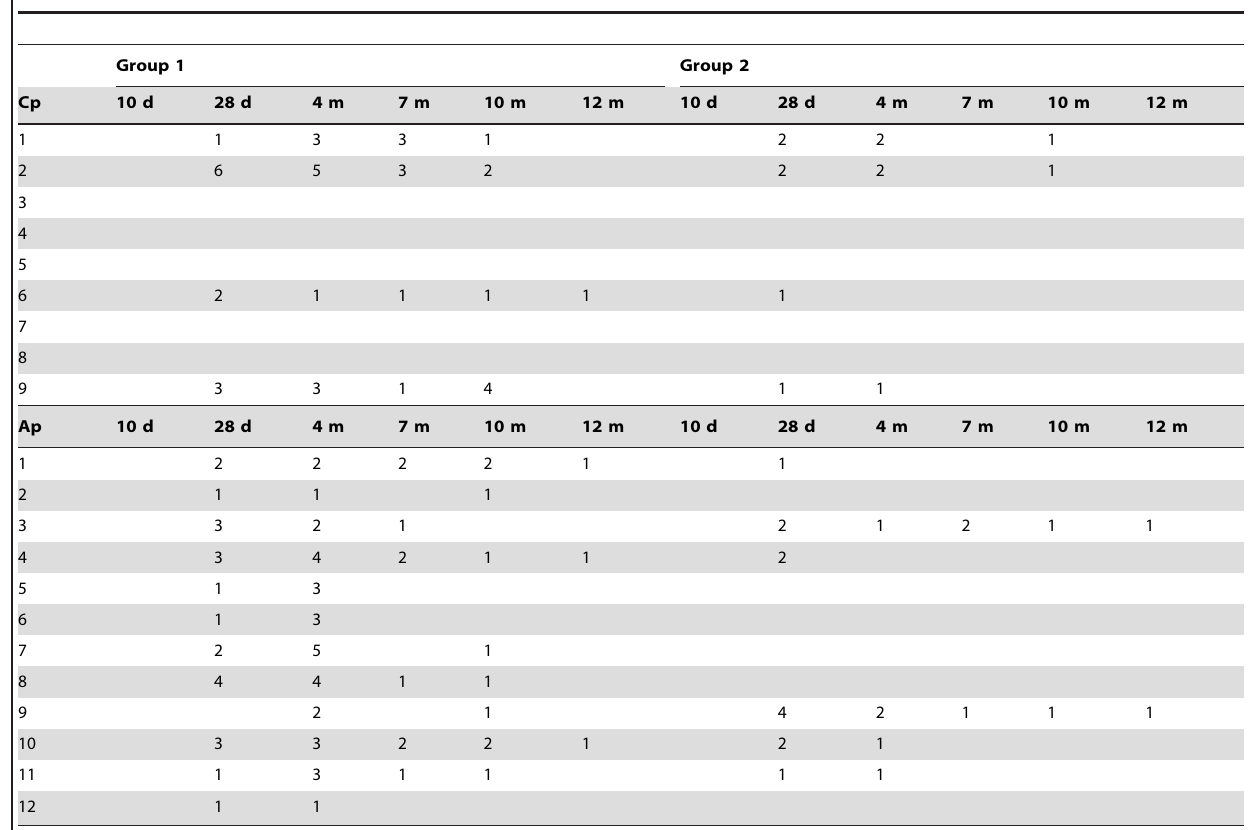
Table 6. Immunodominant CSP and AMA1 peptide pools by ELISpot assay.